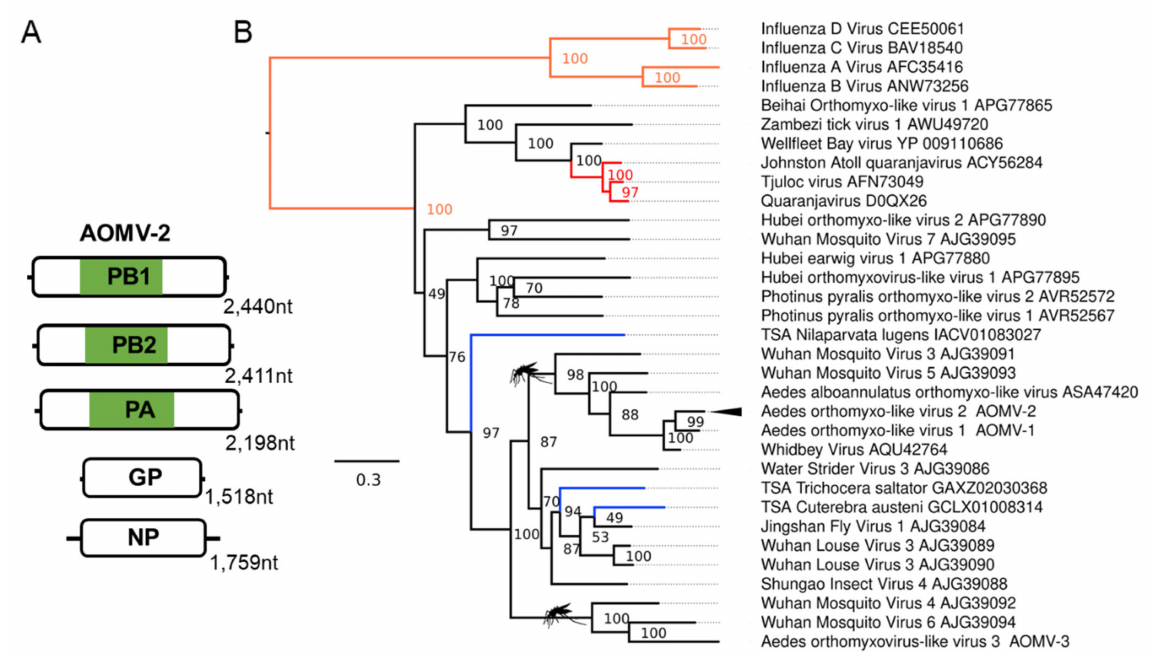
Figure 3. Novel negative-sense RNA viruses of Ae. aegypti and Ae. albopictus mosquitoes. ( A ) Genome structure of the Aedes orthomyxo-like virus 2 (AOMLV-2), PB1/PB2, Polymerase basic 1/2 protein; PA, polymerase acidic protein; GP, putative glycoprotein; NP, nucleoprotein. ( B ) Phylogenetic placement within Orthomyxoviridae constructed using aligned PB1 protein of orthomyxoviruses. Clades are coloured as per the current Orthomyxoviridae taxonomy (ICTV 2018b Release) with influenza viruses (orange) and genus Quaranjavirus (red). Consensus maximum-likelihood trees were made using IQTree with the LG + G4 amino acid substitution model with 50,000 Ultrafast bootstraps and bootstrap support indicated on the node. Each TSA accession is shown in blue. For clarity, the tree is midpoint rooted. Branch length indicates the number of amino acid substitutions per site. Novel viruses are marked with arrowheads. Nodes with a mosquito indicate clades containing viruses identified from mosquito